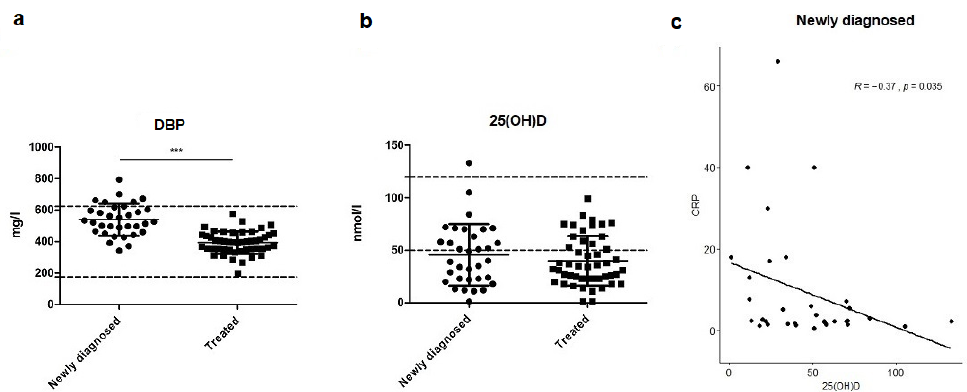
Figure 4. Levels of 25(OH)D and vitamin-D-binding protein in newly diagnosed and treated patients (*** p < 0.0001). ( a ) Levels of vitamin-D-binding protein (DBP) were reduced in treated patients compared with newly diagnosed patients with PAH or CTEPH. ( b ) 25(OH)D levels were not different in newly diagnosed versus treated patients with PAH or CTEPH. ( c ) There was a negative correlation between the levels of 25(OH)D and CRP in newly diagnosed